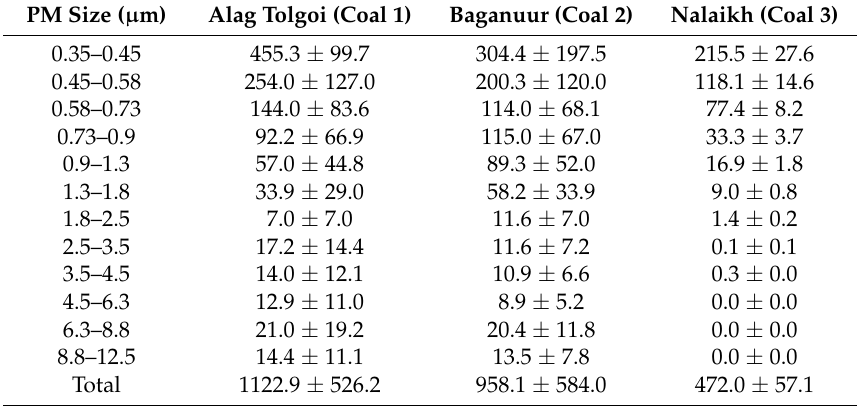
Table 3. PM emission factors (mg/kg) by particle size for the combustion of different coal types.